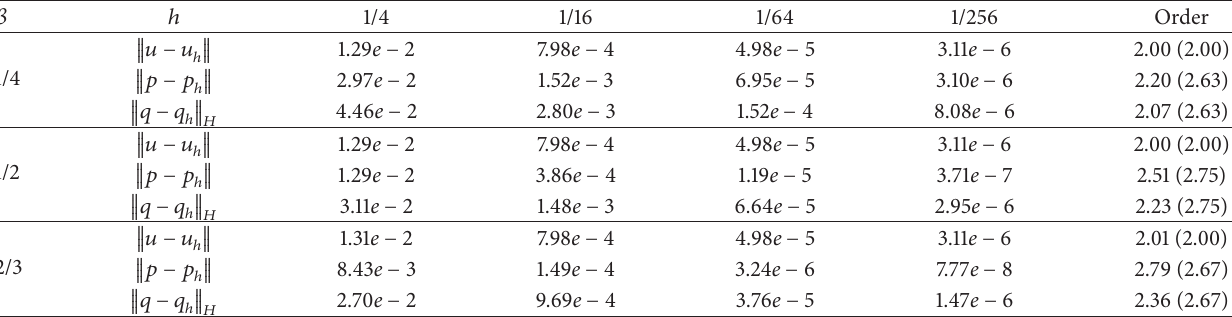
Table 4: Numerical result of Example 2 on a uniform mesh of size ℎ for 𝑘 = 2 .